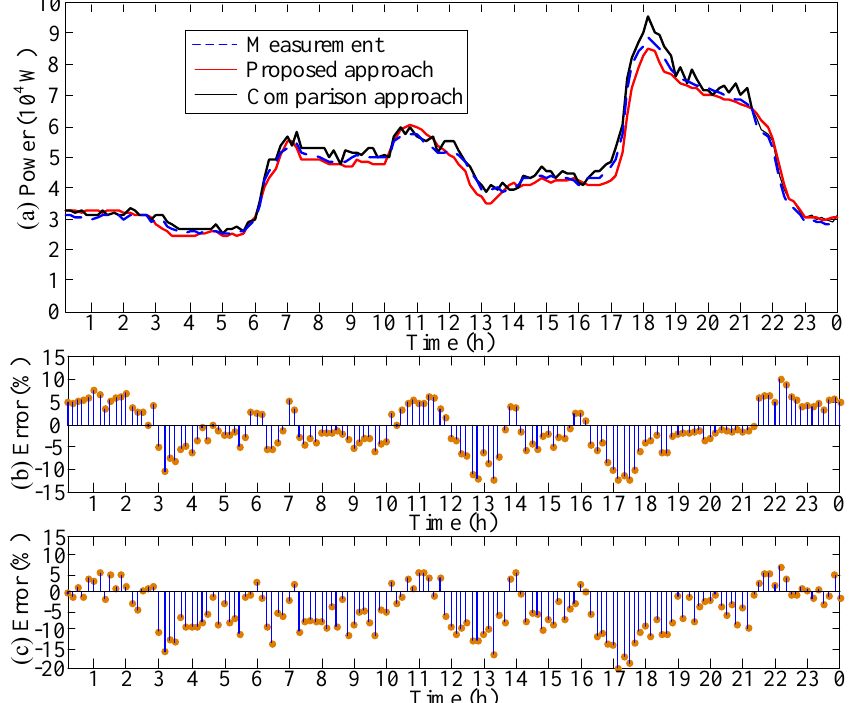
Figure 6. Prediction results for the residential community: ( a ) is the forecasting power; ( b ) is the error between the proposed approach and the measurement; ( c ) is error the between the comparison approach and the